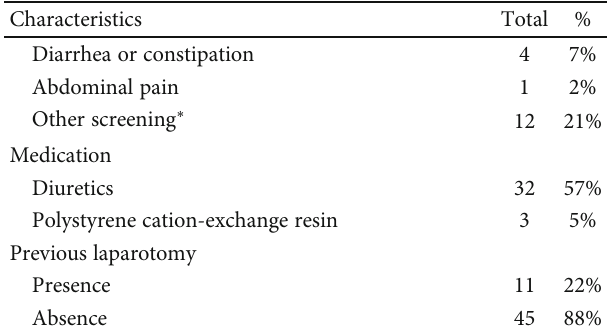
Table 2: Clinical characteristics of patients with chronic kidney